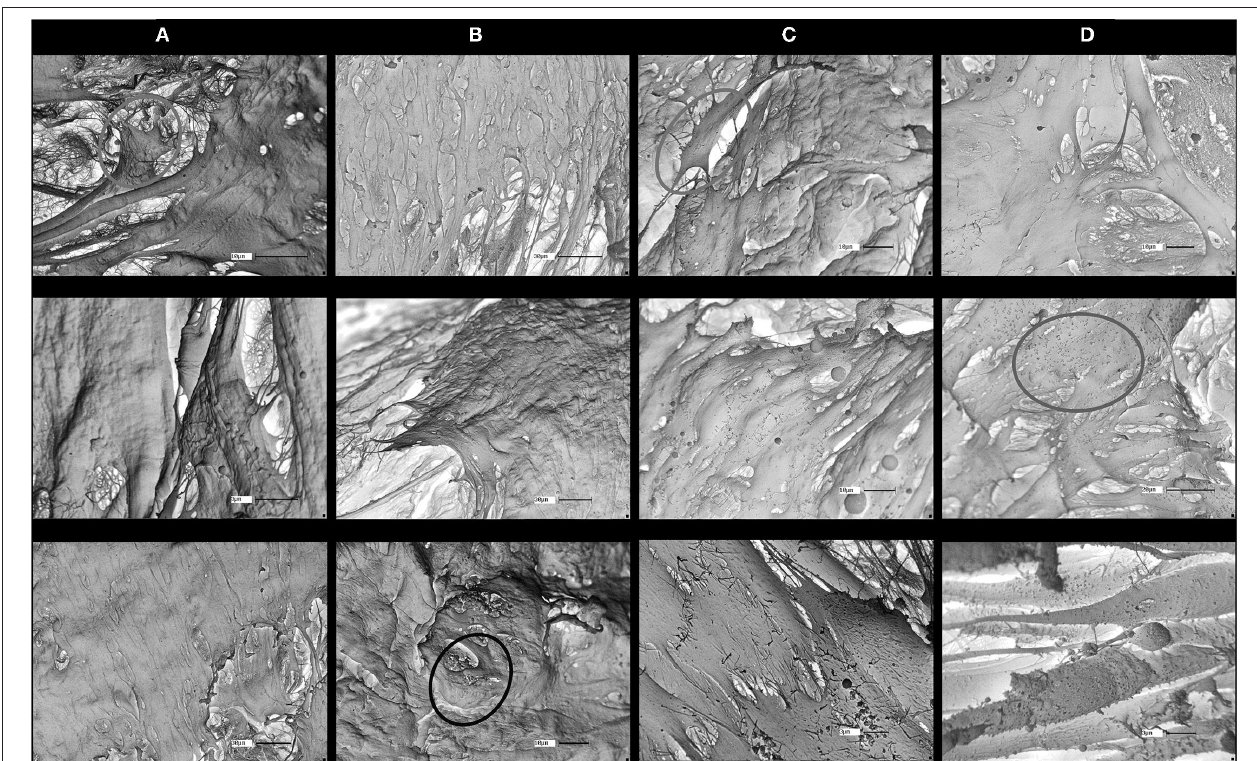
FIGURE 3 | Scan electron microscopy (SEM) of matrices at 41 days of recellularization for the four groups. ASM cells are more evenly distributed and more uniform in (A) control matrices/control ASM cells and in (B) control matrices/asthmatic ASM cells than in (C) asthmatic matrices/control ASM cells and in (D) asthmatic matrices/asthmatic ASM cells. Large collagen deposits (yellow circles) are visible in the control matrix/asthmatic ASM cell groups and cell debris (green circle) are present particularly in asthmatic matrices/asthmatic ASM cells. Red circles refer to examples of fibroblast shape. Magnifications are specified on each